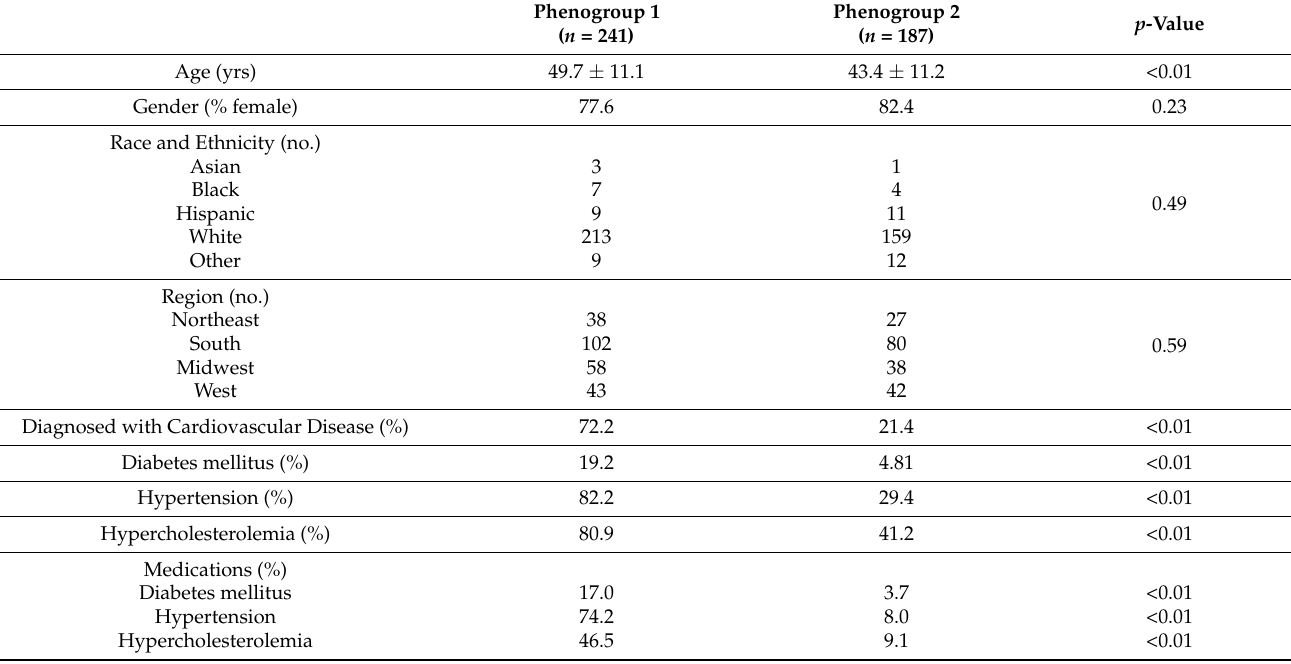
Table 2. Former smoker self-reported demographics and ideal cardiovascular health data.